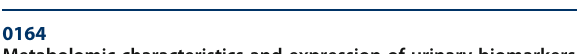
Table 1 (abstract 0164). Description of the cohort undergoing cardiac surgery